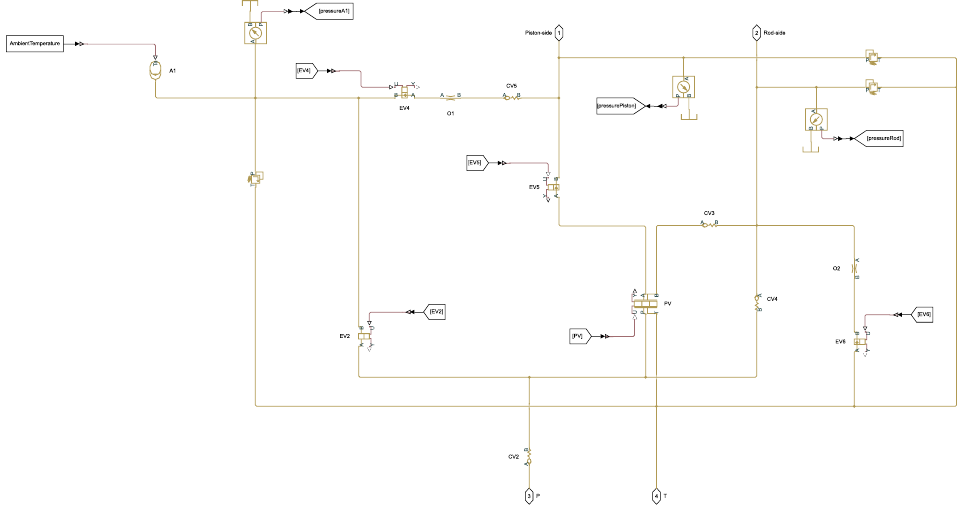
Figure 6. Individual blade manifold